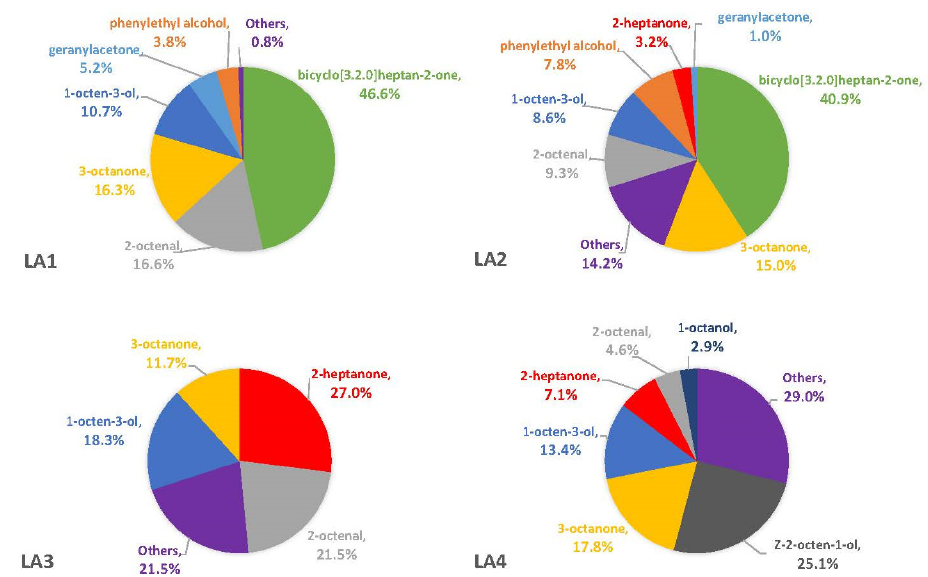
Figure 1. Average percentages (over three replicates) of VOCs contributing to total headspace profile of each Aspergillus strain while growing on YES medium.